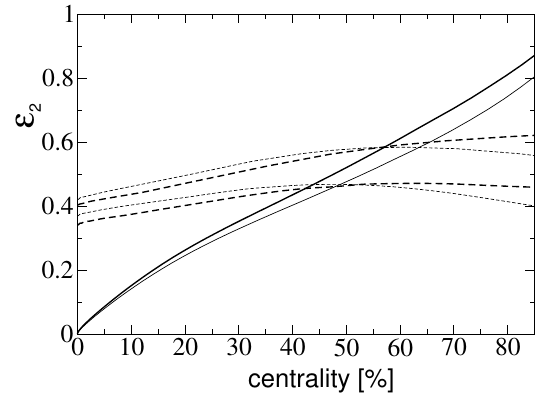
Figure 2 . Centrality dependence of the initial fireball eccentricity (cid:15) 2 for O+O collisions at √ s = 0 . 2 TeV (thin lines) and 7 TeV (thick lines) calculated in the optical (solid) and in the Monte- Carlo (dashed) Glauber wounded nucleon model. The curves for the Monte-Carlo version are obtained for the Gaussian width parameter of the entropy sources (top to bottom) 0 . 4 and 0 . 7